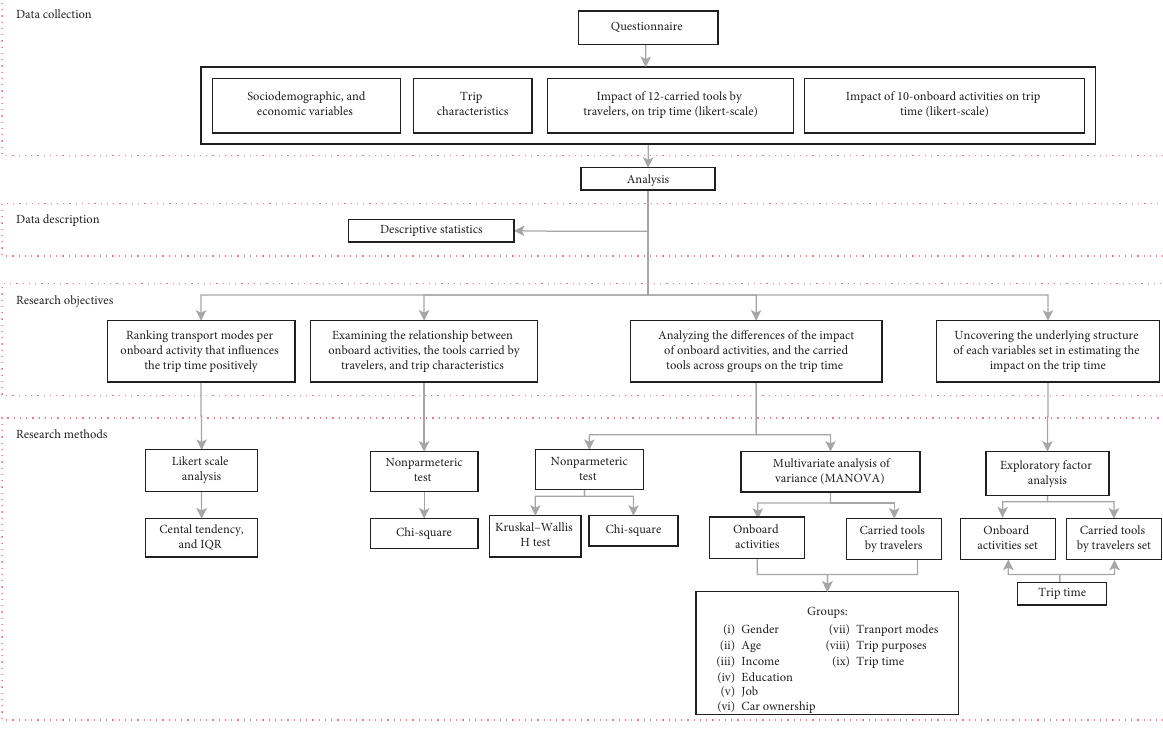
Figure 1: The methodological